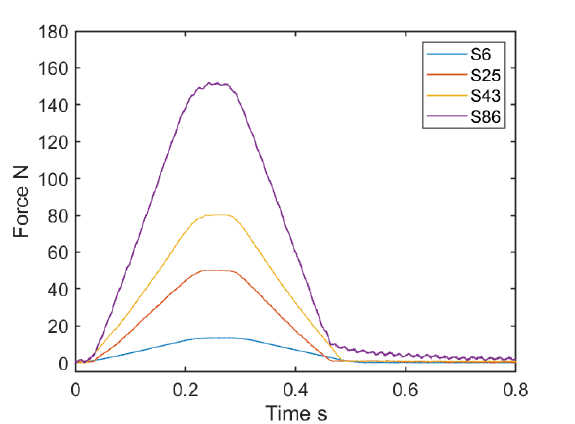
Figure 5. Force measured based on the 2 mm displacement of the probe of the four texture sensors equipped with different